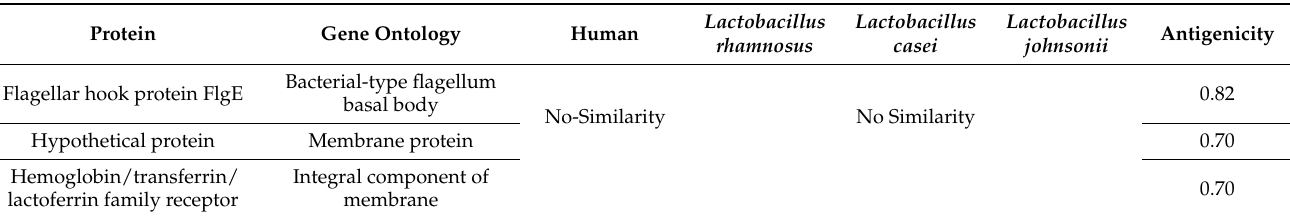
Table 2. Homology check of protein with human genome and normal flora, antigenicity, allergenicity, and adhesion probability